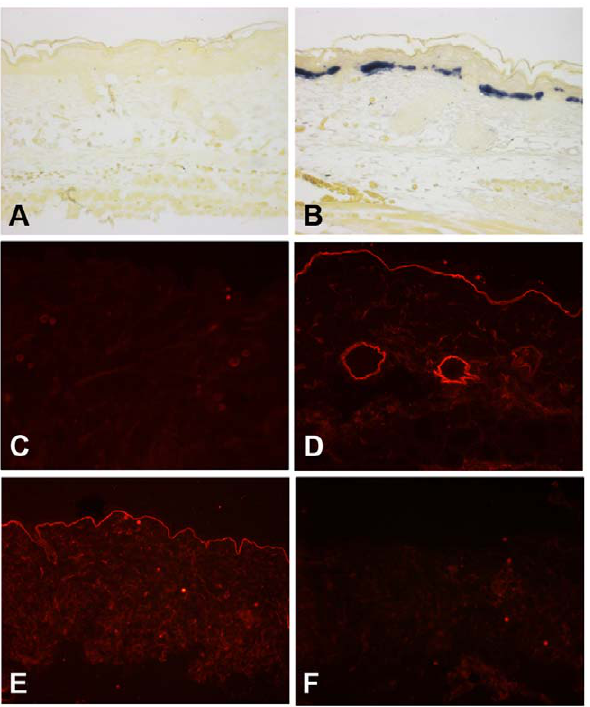
Figure 3. Human laminin c 2 is expressed by keratinocytes and deposited into the basement membrane. Skin tissue sections from adult Lamc2 WT (A–C) and rescued Lamc2 KO mice (D–F) were subjected to in situ hybridization for human laminin c 2 mRNA using a digoxigenin-labeled RNA probe (A and D) or immunostaining for human (B and E) or mouse (C and F) laminin c 2 using species-specific laminin c 2 antibodies and TRITC-conjugated secondary antibodies. Blue staining in panels A and D represents positive hybridization. Sections were counterstained with tartrazine yellow for contrast. The lack of staining in panels A and B show that the absence of human laminin c 2 expression in Lamc2 WT mice. The lack of staining in panel F shows the absence of mouse laminin c 2 in the rescued Lamc2 KO mice.